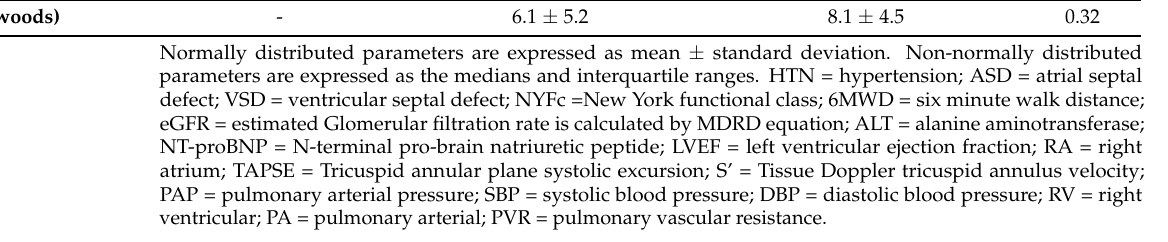
Table 2. The univariate and multivariable Cox regression analysis of hospitalization for heat failure in patients with congenital heart disease- (CHD) related pulmonary arterial hypertension (PAH).